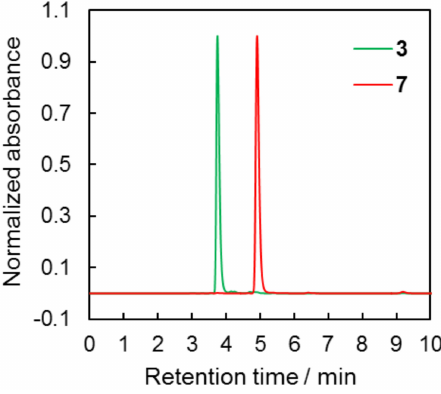
Figure 4. Chromatograms of compounds 3 and 7